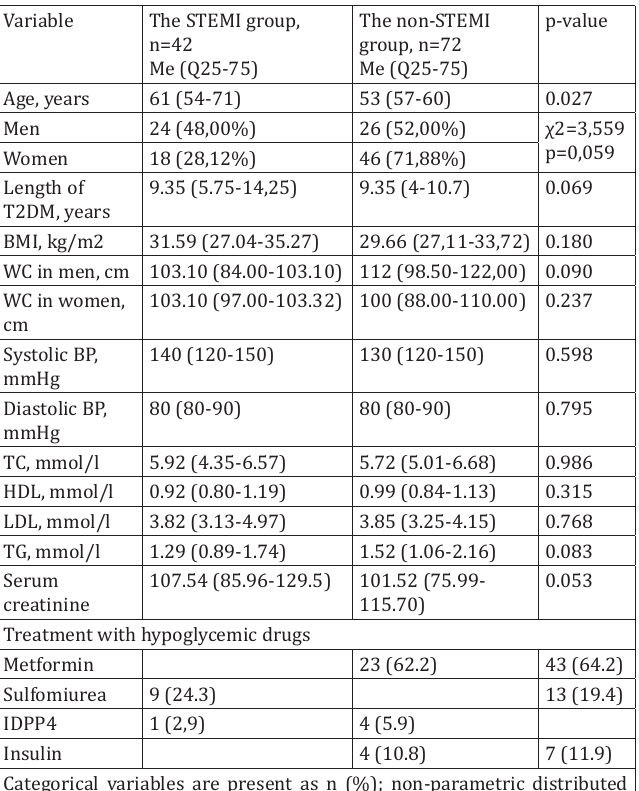
Baseline characteristics of patients